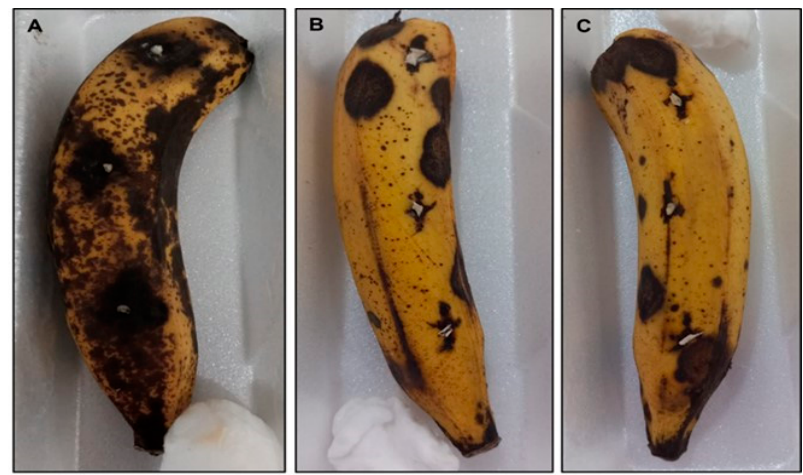
Figure 8. Banana fruits inoculated with Colletotrichum musae and untreated and curatively treated with the coumarin standard. ( A ) Fruits inoculated with phytopathogen (control) and sprayed with water. ( B ) Fruits inoculated with the phytopathogen and sprayed with coumarin (40%). ( C ) Fruits inoculated with phytopathogen and sprayed with coumarin (50%).